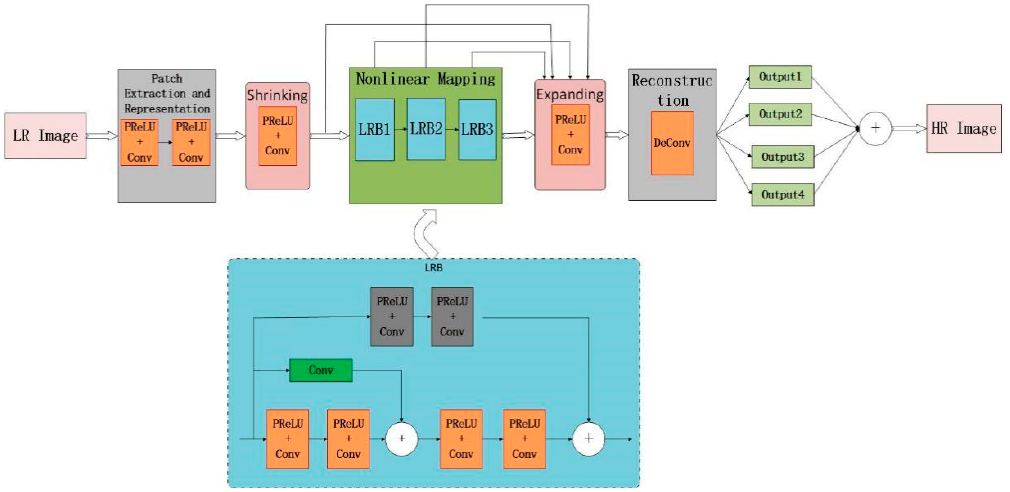
Figure 2. The proposed super-resolution image reconstruction framework.